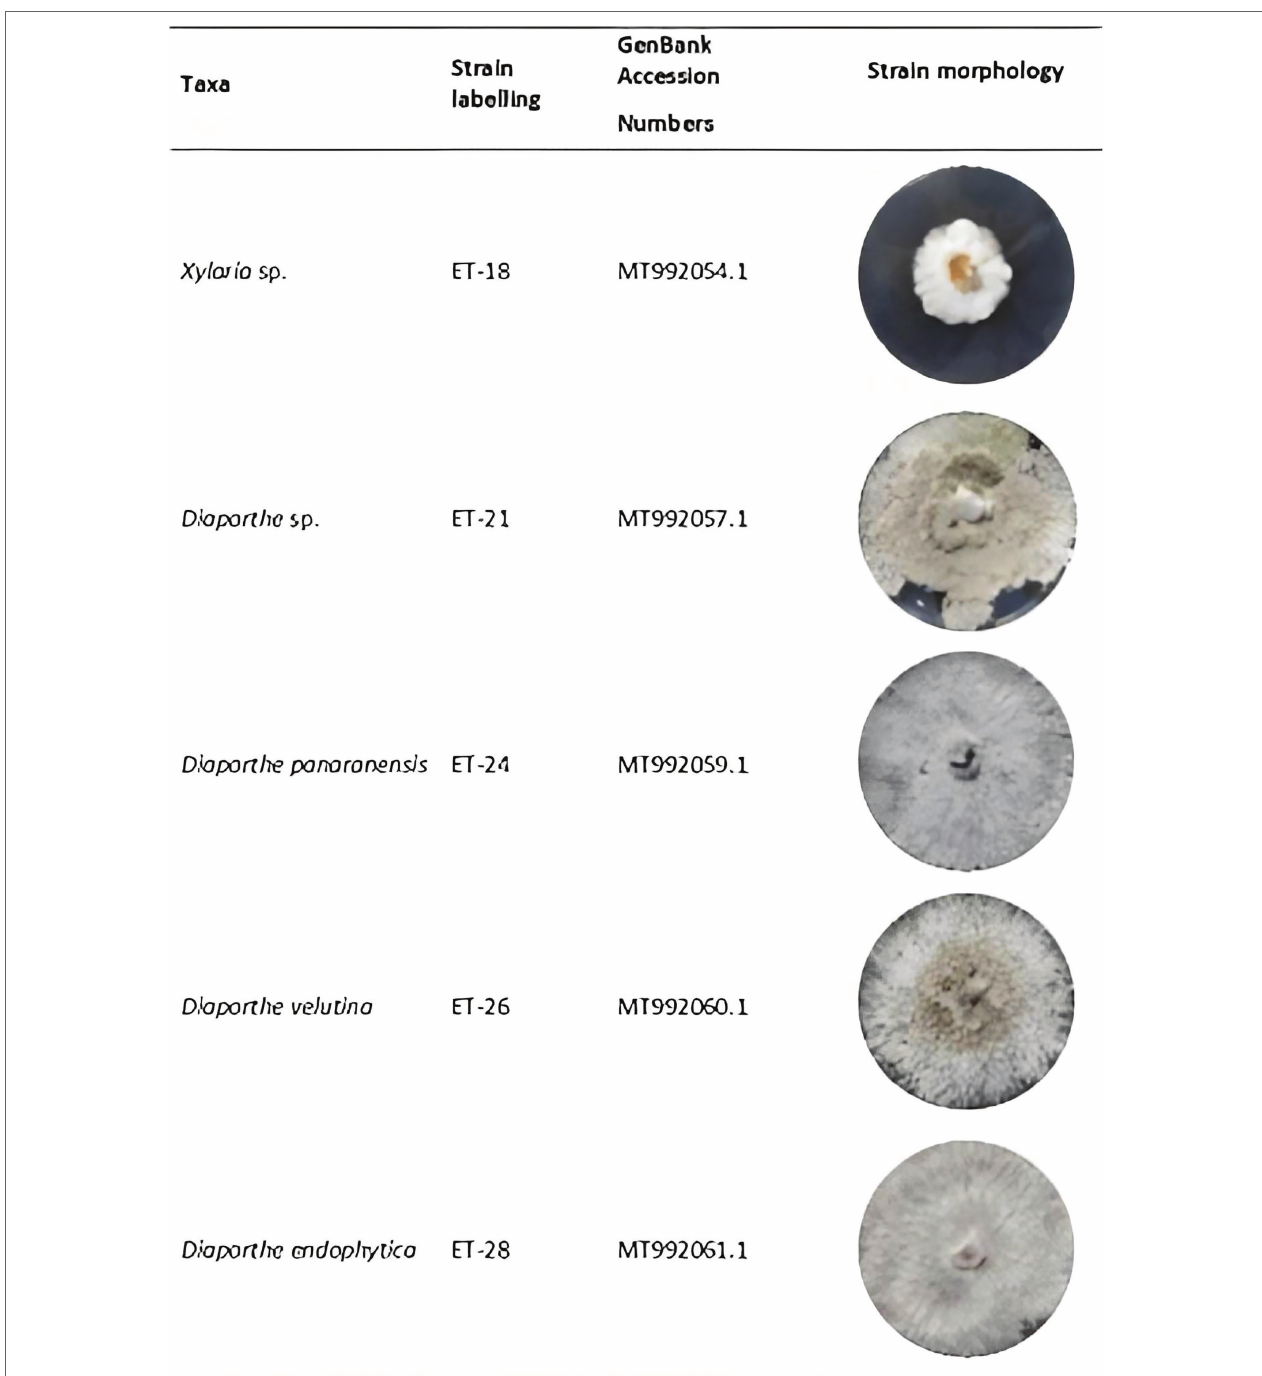
FIGURE 3 | Taxonomic information of endophytic strains and mycelial growth on potato dextrose agar (PDA) after 8 days incubation at 29 °